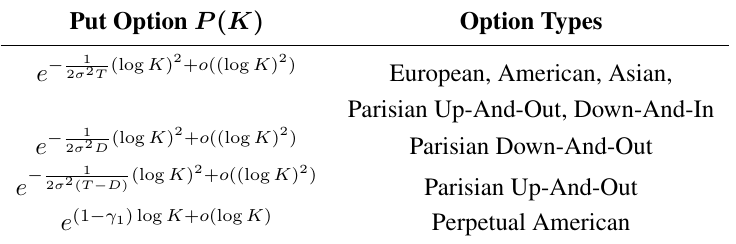
Table 2. Summary of four categories for put option prices at extreme strikes, where T is the < 0 is a constant depending on r, q, σ maturity, D is the option window and γ 1